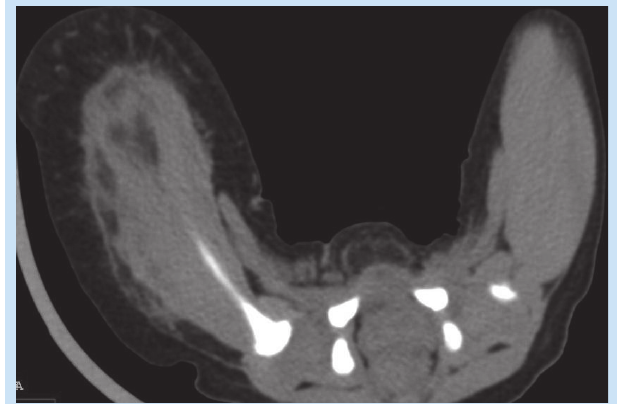
Fig. 4. Axial CT demonstrating fibrous stranding within the thickened sub- cutaneous fatty